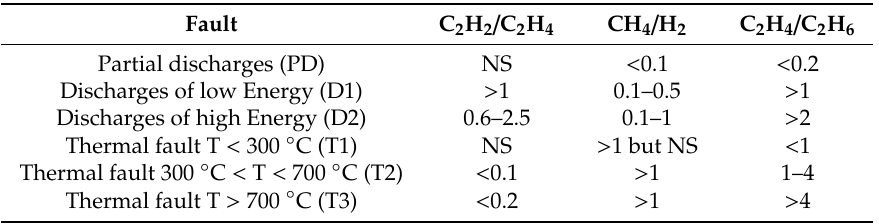
Table 5. Interpretation scheme of gas ratios for bushings proposed in the IEC 60599